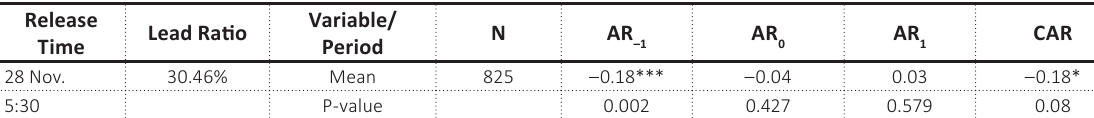
Table 4. Cumulative abnormal returns for the Liberty Times polls Panel A. CAR for initial poll